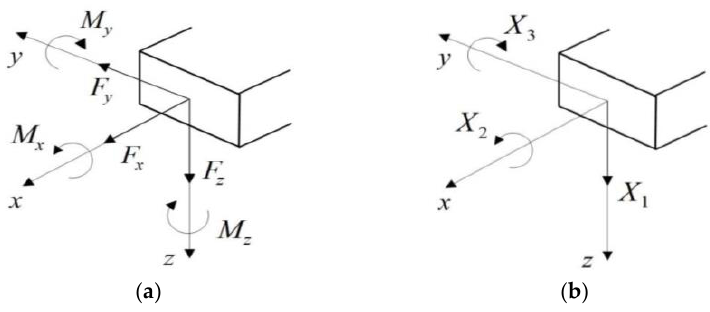
Figure 6. Generalized forces added on the released end.